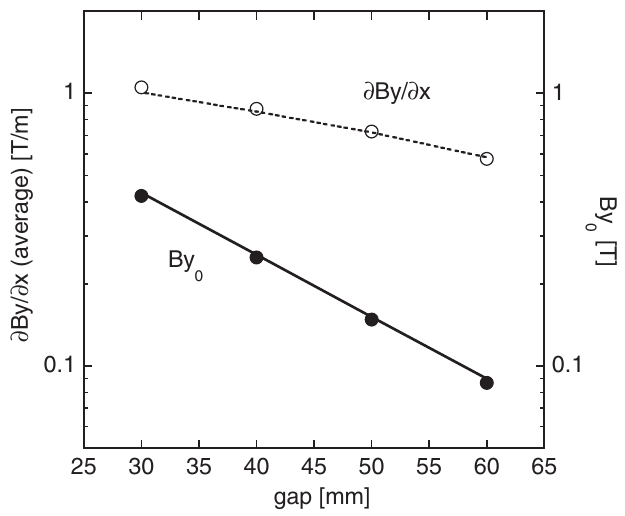
FIG. 10. Peak magnetic field and the field gradient of the EF wiggler as a function of the wiggler gap. The solid circles and the open circles show the measured peak magnetic field and the average field gradient over a wiggler period, respectively. The solid and the dashed lines show calculation using the 3D pro-